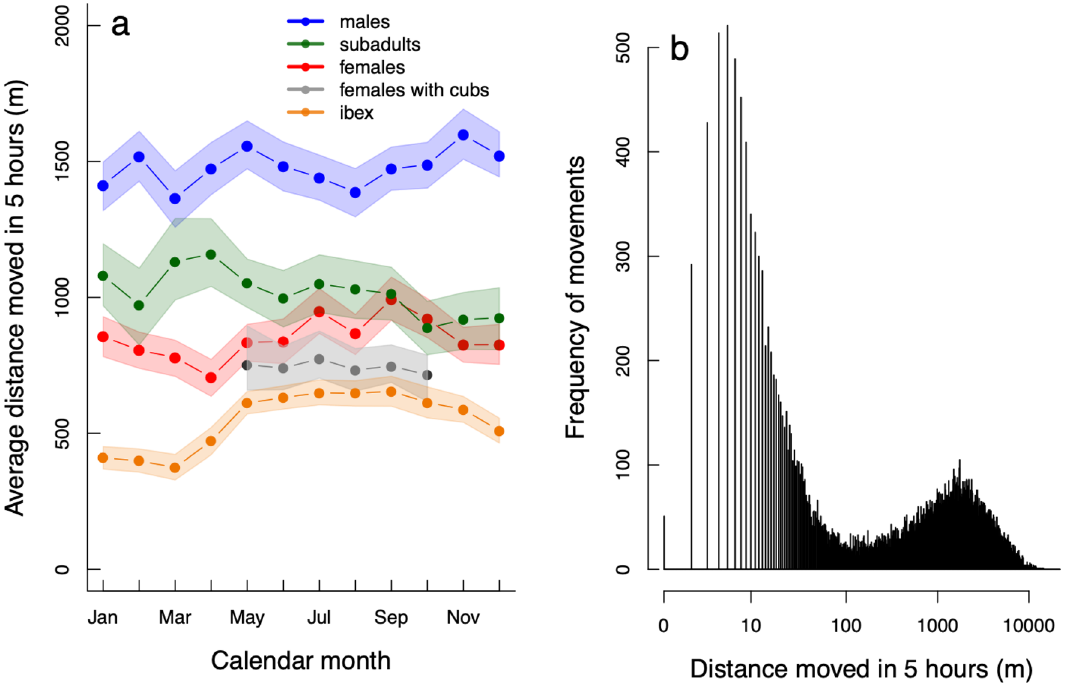
Figure 1. Summary of GPS-movement data: ( a ) mean 5-hourly movement distance (in meters) for each calendar month for snow leopards (adult males = blue, subadults = green, adult females = red, females-with- young-cubs = grey) and for ibex (orange). The monthly estimates were generated from a random-effects GLMM with the joined points representing the mean and the shaded area the 95% CI of the mean. Ibex estimates were from hourly data and were therefore rescaled to be made comparable to the 5-hourly snow leopard estimates. ( b ) Histogram of the log-transformed snow leopard GPS-movement data (male and female adults combined) showing the frequency of observed snow leopard movements related to the distance they moved from one GPS position to the next (5 h later). For separate histograms of males and females see Supplementary Figure